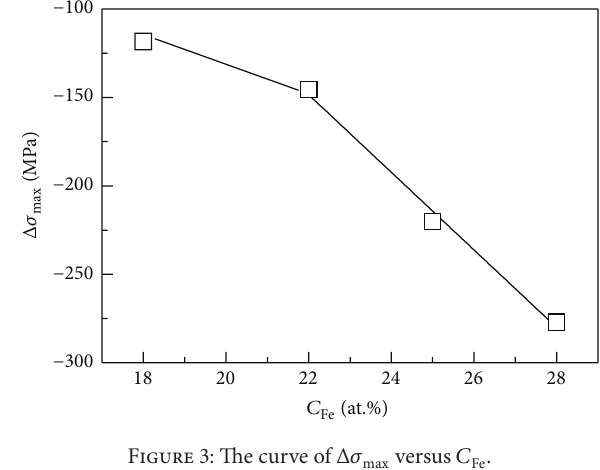
Figure 3: The curve of Δ𝜎 max versus 𝐶